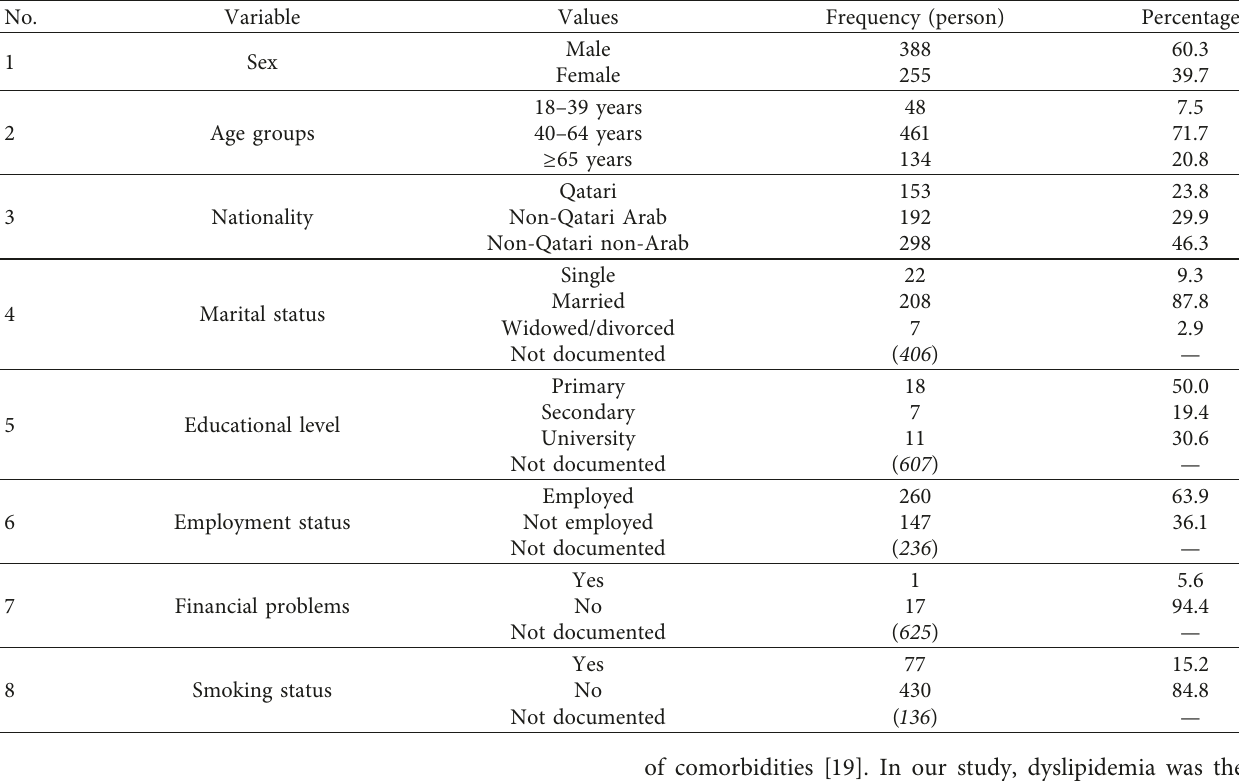
Table 1: Distribution of patients by their sociodemographic factors ( N � 643).